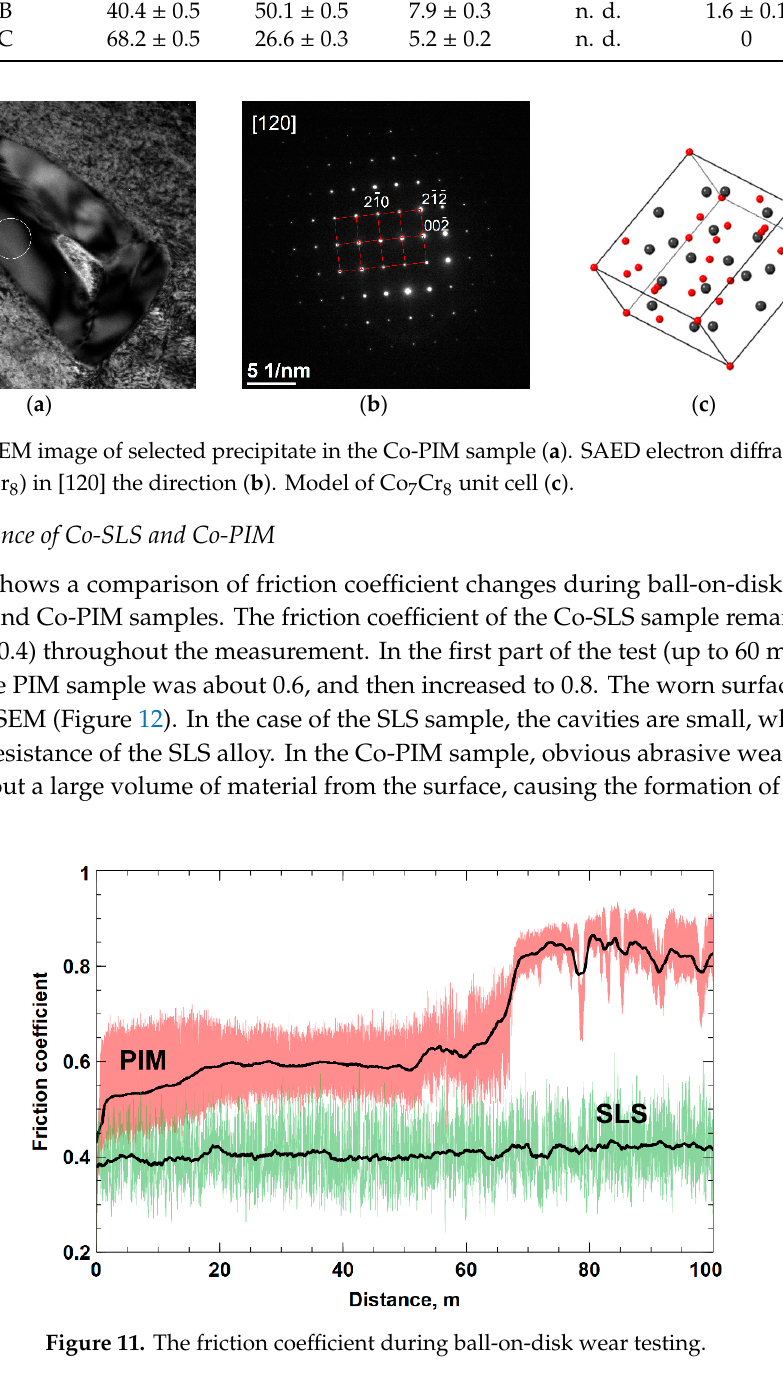
( a ) ( b ) Figure 12. SEM images of wear scars of the ( a ) Co-SLS and ( b ) Co-PIM samples. 4. Discussion Excellent wear resistance is one of the characteristics of Co-Cr alloys. Additive manufacturing for metals and powder injection molding have recently received much attention as techniques for producing complex three-dimensional structures with excellent wear resistance from precursor powders. Our research results make it possible to compare the structure and abrasive wear of materials made with these techniques. Differences for materials obtained from powders using SLS and PIM were visible during wear resistance measurements. The friction coefficient of the Co-SLS sample had a lower value and remained constant throughout the measurement. For the PIM sample, the value of this coefficient was higher from the beginning and increased in the second half of the test. It is known that mechanical and tribological properties of Co-based alloys strongly depend on their microstructure [30–32]. For example, friction coefficient is mainly influenced by microstructure, and the roughness impact is less important [33]. The use of electron microscopy and XRD allowed us to show that Co- SLS and Co-PIM have different structures and to link these differences with observed wear behavior. Both materials are homogeneous, compact, and without porosity. The grain size is limited in both cases. A smaller grain size leads to a higher yield strength for the alloy, according to the Hall– Petch equation. Smaller grain sizes indicate the presence of more grain boundaries per unit area. Such boundaries act as impeding points to dislocation propagation; as a result, greater applied stress is needed for the dislocation propagation. However, the main factor determining wear resistance of